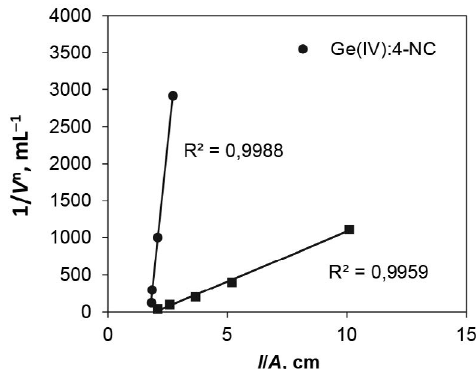
Figure 3. Determination of the molar ratios by the straight-line method of Asmus; C Ge(IV) = 2.0 × 10 –5 mol L –1 ; pH = 4.0; λ = 420 nm; τ = 2 min; • Ge(IV):4-NC, C TV = 3.0 × 10 –4 mol L –1 , ■ Ge(IV):TV, C